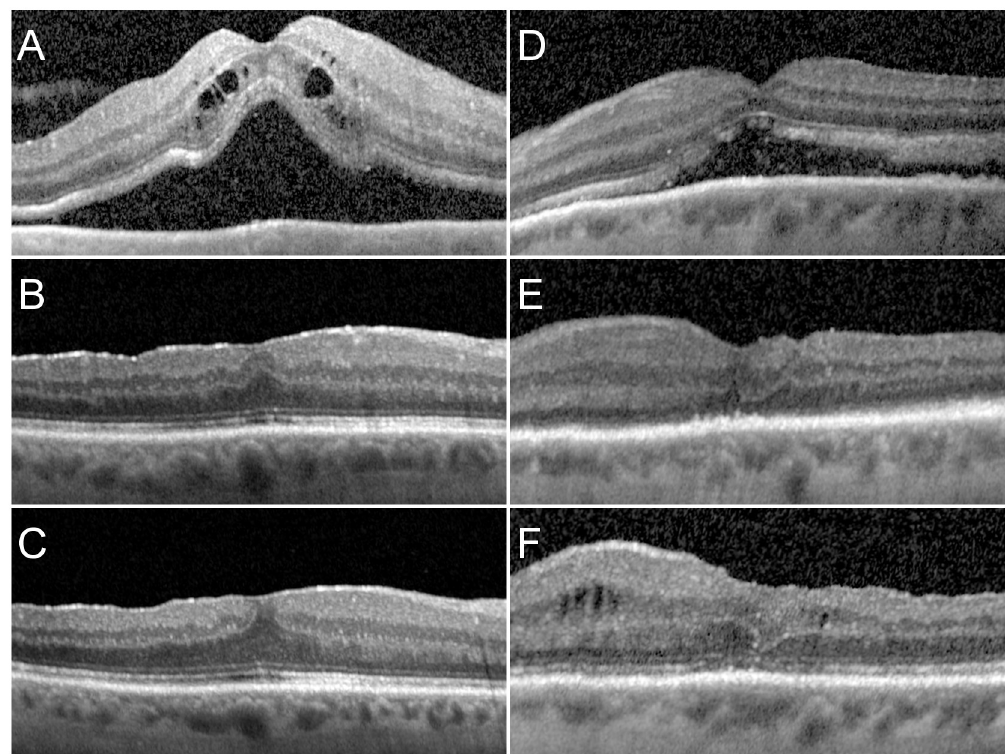
Fig 6. Exemplary evolution in two instances. Left column A–C: A patient with foveal detachment reporting visual loss for 14 days and a preoperative visual acuity (VA) of 0.7 logMAR and a reading acuity (RA) of 0.3 logRAD before surgery (A), with good visual and morphologic recovery (ELM 1, EZ 2, VA -0.1, RA 0.0) after 1 month (B), and further morphological improvement after 6 months (ELM 1, EZ 1, VA -0.1, RA 0.0) (C). Right column D–F: A patient with foveal detachment reporting visual loss for 30 days (D), with limited early functional recovery (VA 0.9 logMAR, RA 0.7 logRAD) and morphological improvement (ELM 3, EZ3) (E), and slight but still incomplete recovery after 6 months (VA 0.7 logMAR, RA 0.7 logRAD) and persisting structural alterations (ELM 2, EZ 2)